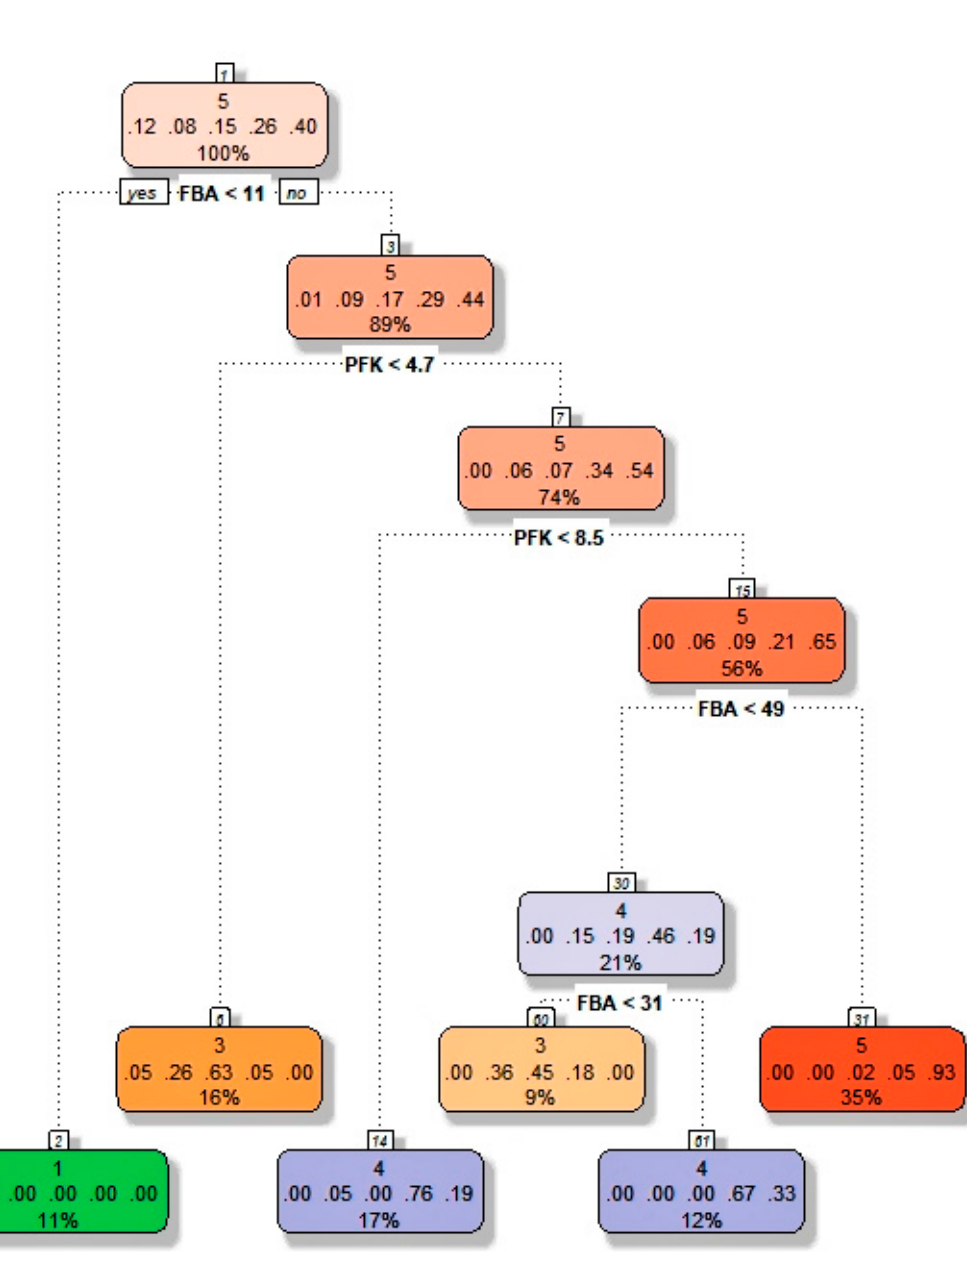
Figure 4. Decision tree analysis for Fievet et al. [43] data to obtain the rule for higher flux ( ≥ 12 µ M / s). The data is classified into 5 groups (i.e., flux value from (0.728–3.17), (3.17–5.6), (5.6–8.04), (8.04–10.5) and